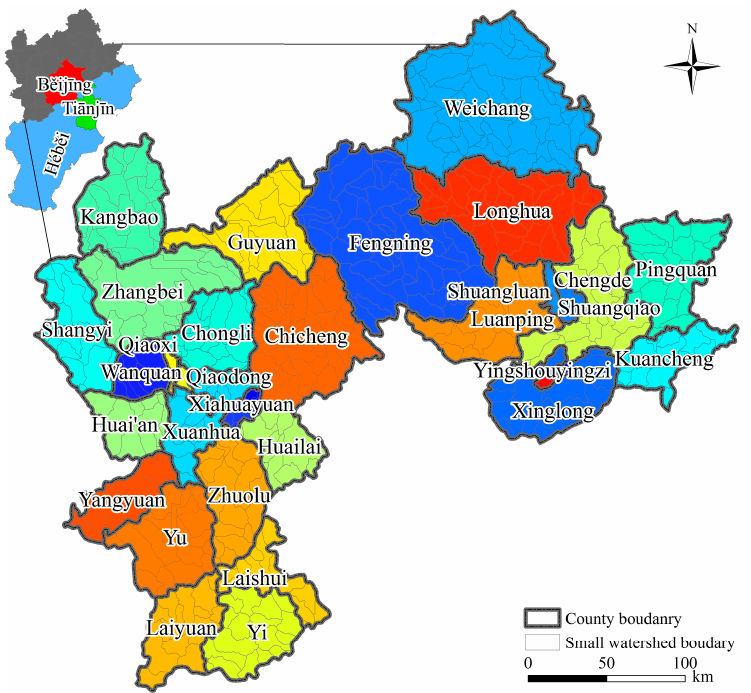
Figure 1. Location of the Poverty Belt around Beijing and Tianjin.